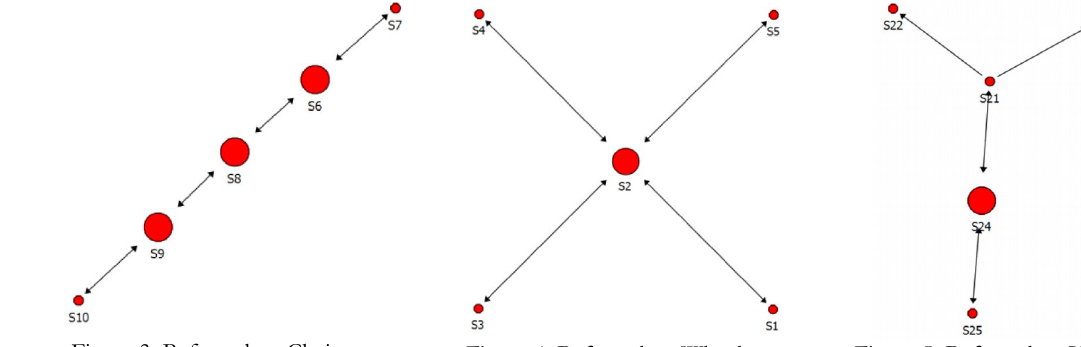
Figure 3. Before class-Chain type Figure 4. Before class-Wheel type Figure 5. Before class-Y type